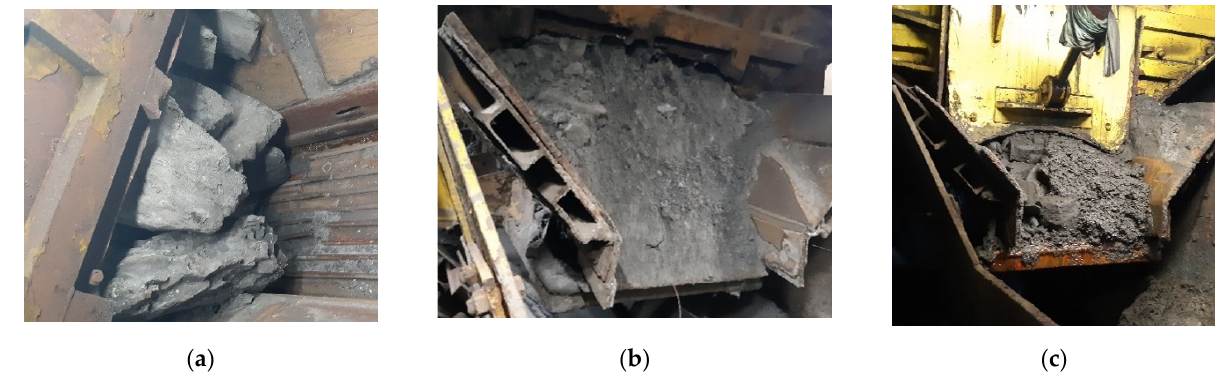
Figure 13. Number of repairs for the elements A, B, C, and D, and the daily failure indicator for the individual mining units in the mine.